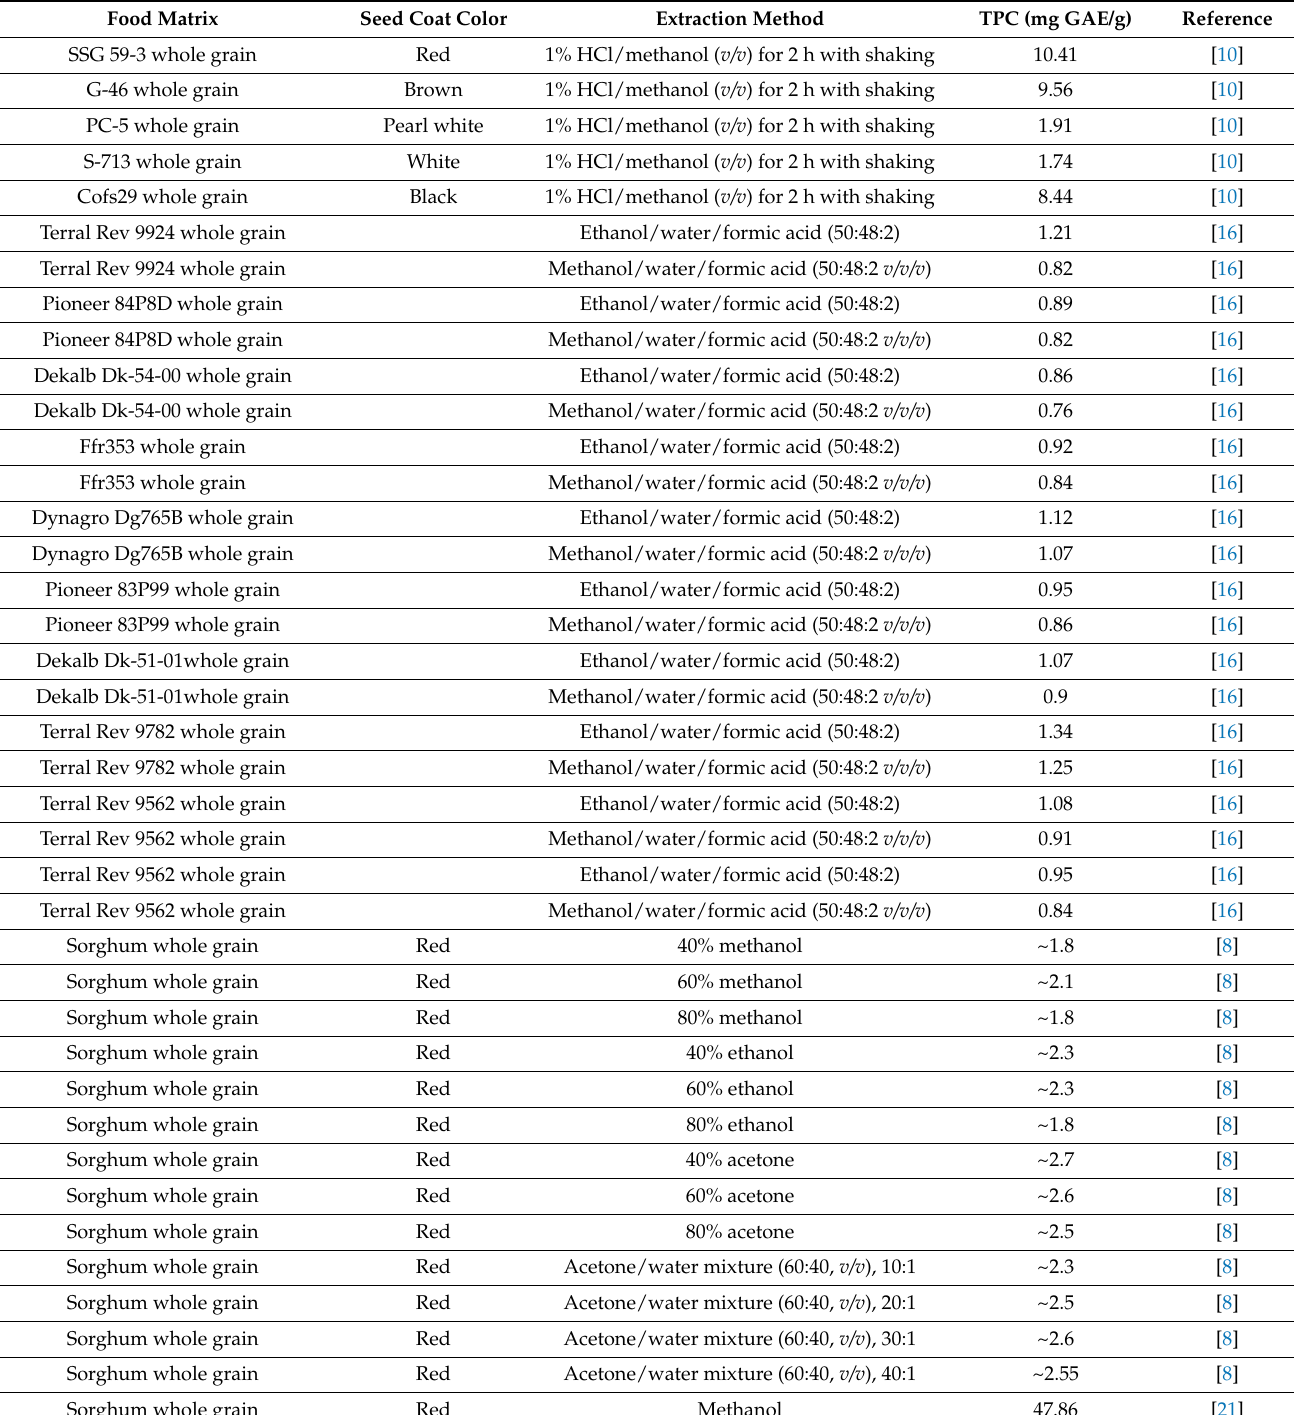
Table 1. Total phenolic compounds (TPC) in sorghum